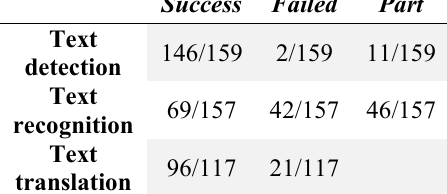
Table 3. Number of images detected, recognized and translated in formed